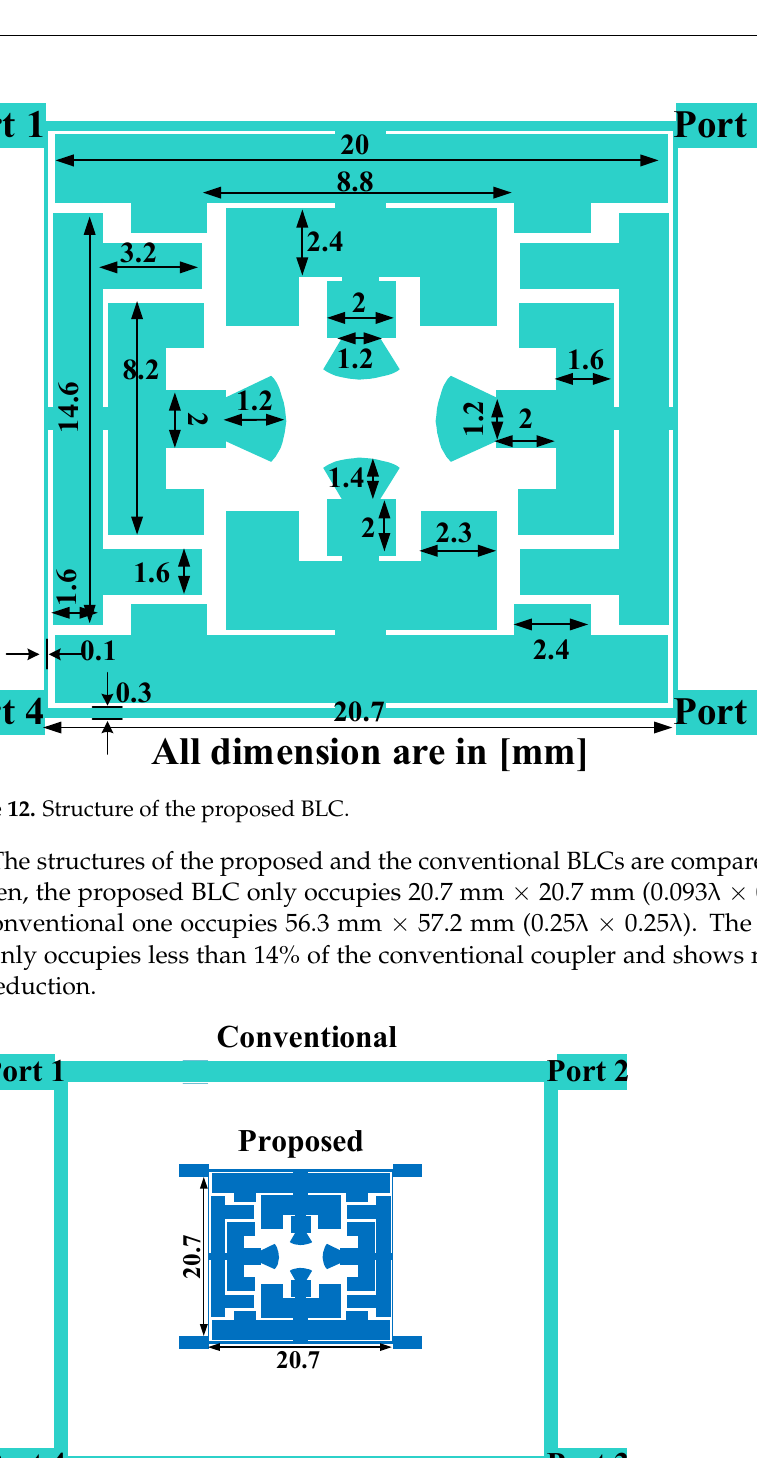
( b ) Figure 11. Final vertical resonator: ( a ) layout and ( b ) frequency response. All dimensions are in the millimeter unit.